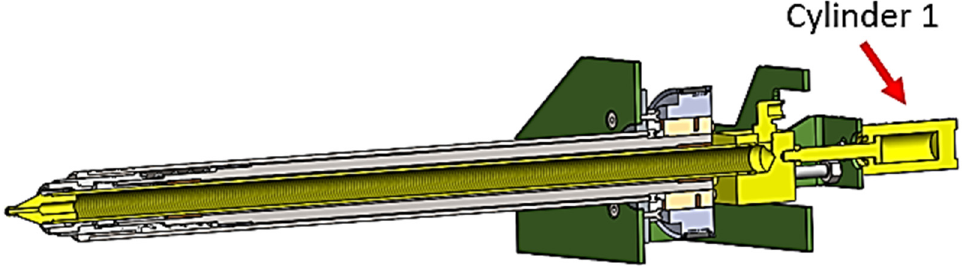
Figure 8. Sectional view of the mechanism responsible for picking up and expanding the expandable pneumatic shaft.